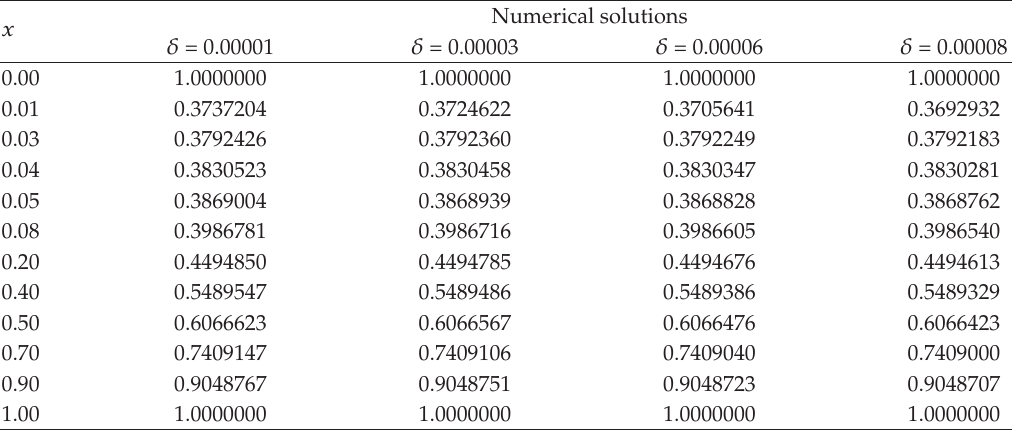
Table 8: Numerical results of Example 4.3 for ε (cid:8) 0 . 0001, N (cid:8) 100, and di ff erent values of δ .